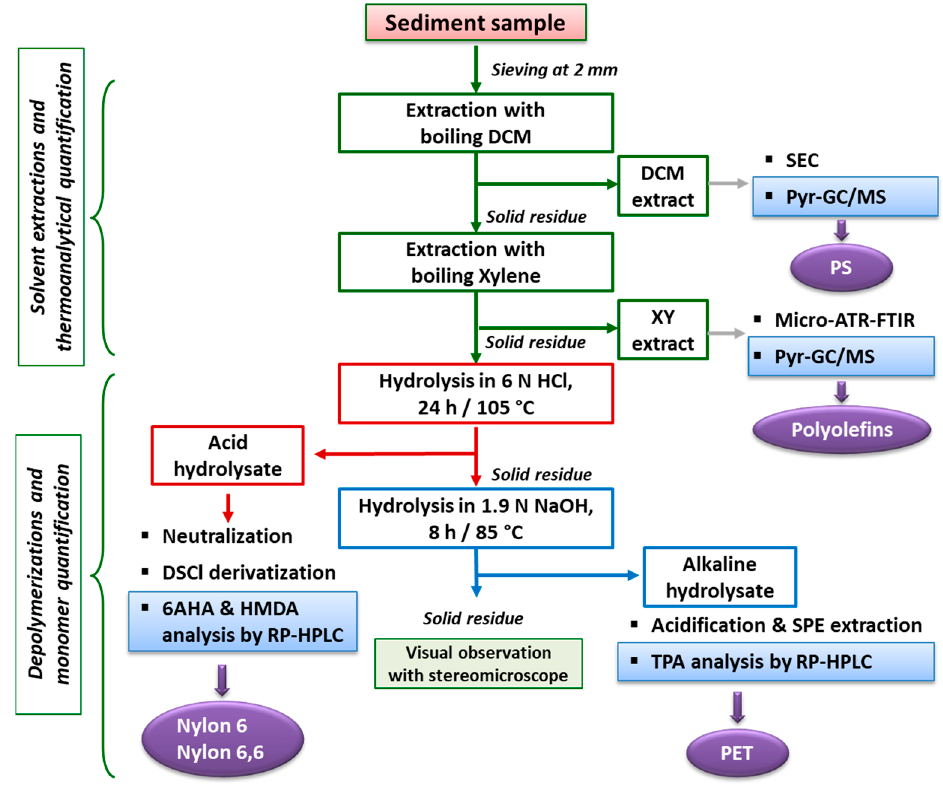
Figure 10. Flowchart of the entire analytical protocol for the separate quantification of the total mass of micro- and nanoparticles of different polymer types.